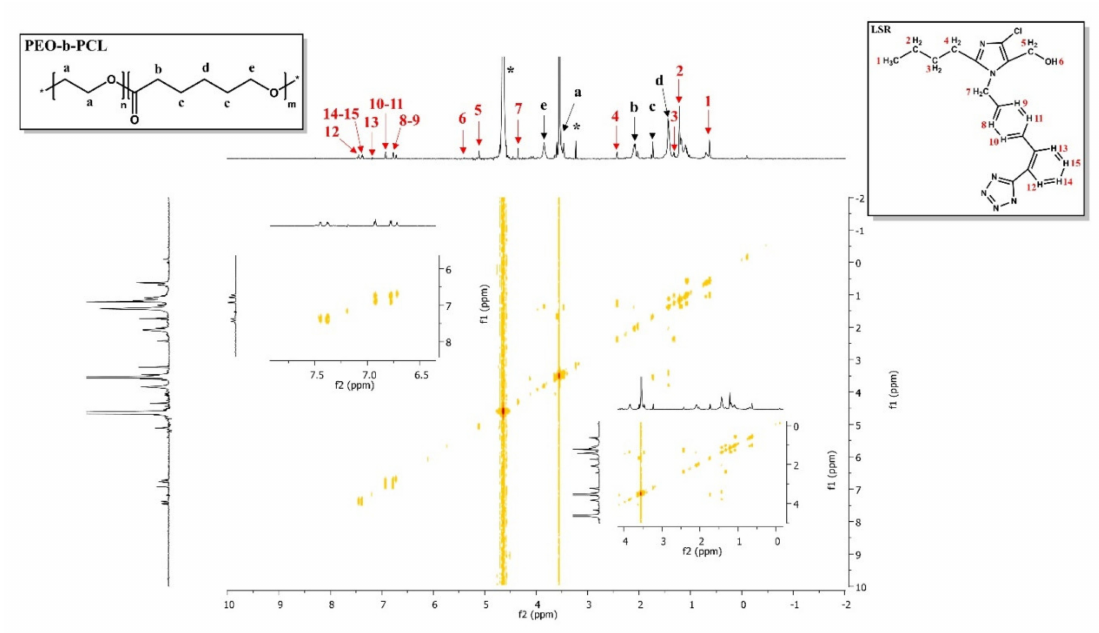
Figure 8. 2D-COSY spectrum of PEO-b-PCL + 50% LSR nanocarriers, where the black letters (a–e) denote the protons of the copolymer structure, the red letters point to the LSR peaks and the asterisk refers to the solvent D 2 O. Eminent correlations are those between the protons within the copolymer and